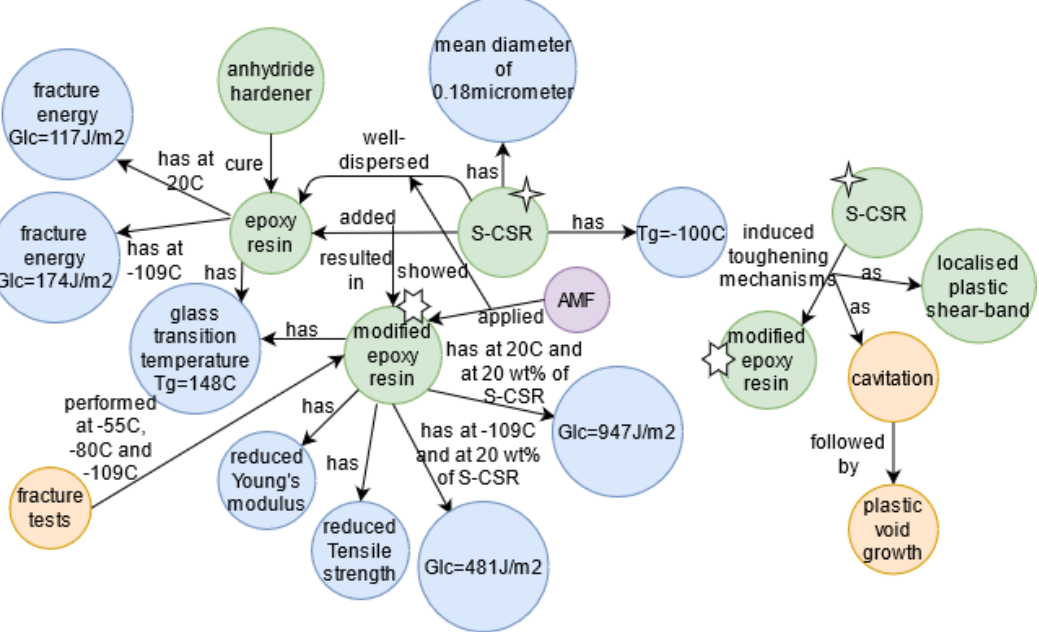
Figure 12. Structured Knowledge Graph (KG) representation of a Material Science domain publication Abstract [64] as process, method, material, and data typed entities. For KGs in the remaining 9 STEM domains we consider, see Appendix